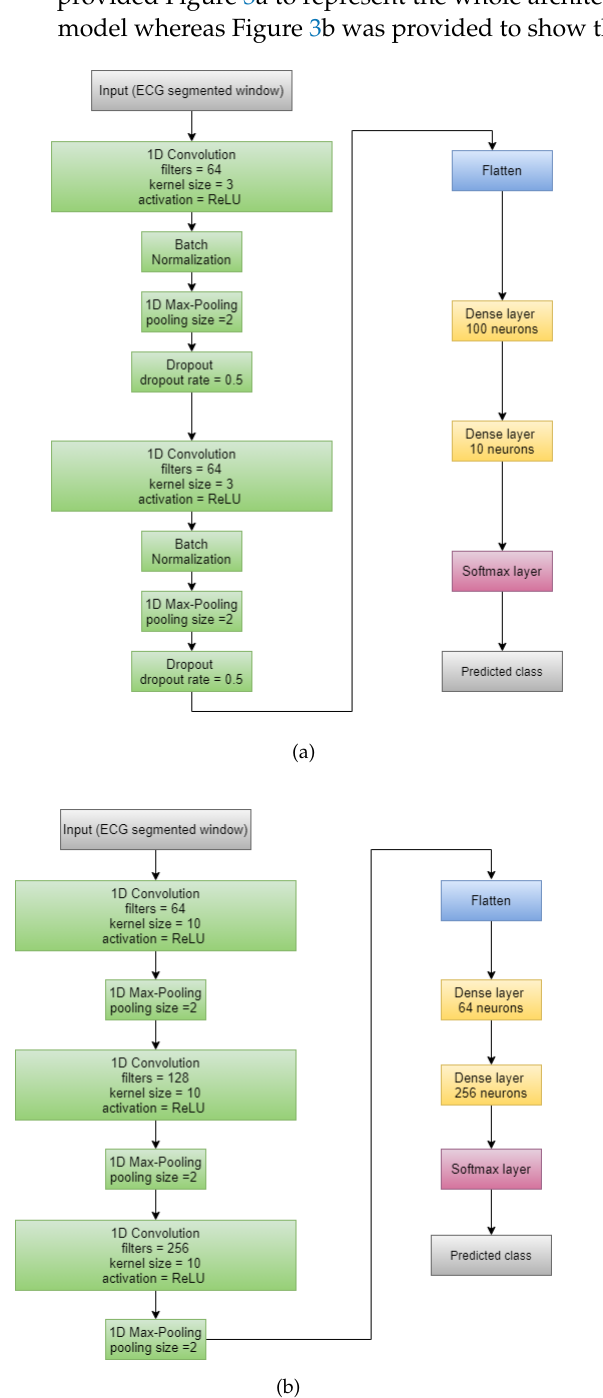
Figure 2. Architectures of the CNN models originally proposed by ( a ) Wang et al. [7] and ( b ) Sha- ran et al. [8]